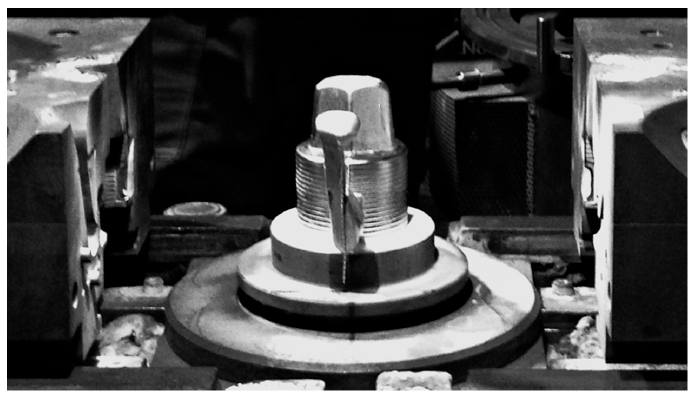
Figure 2. Mold cast of semi-finished AlSi7Mg2Sr0.03/SiC p 10 vol % composite piston.